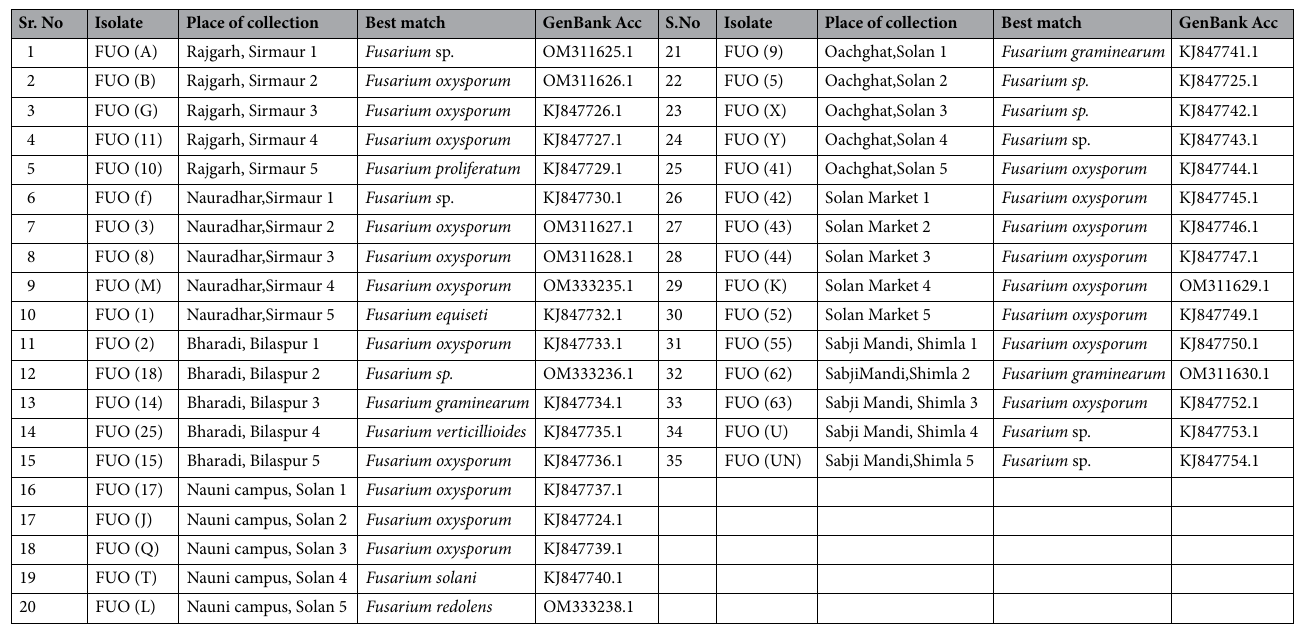
Table 1. GenBank accession numbers of the Fusarium